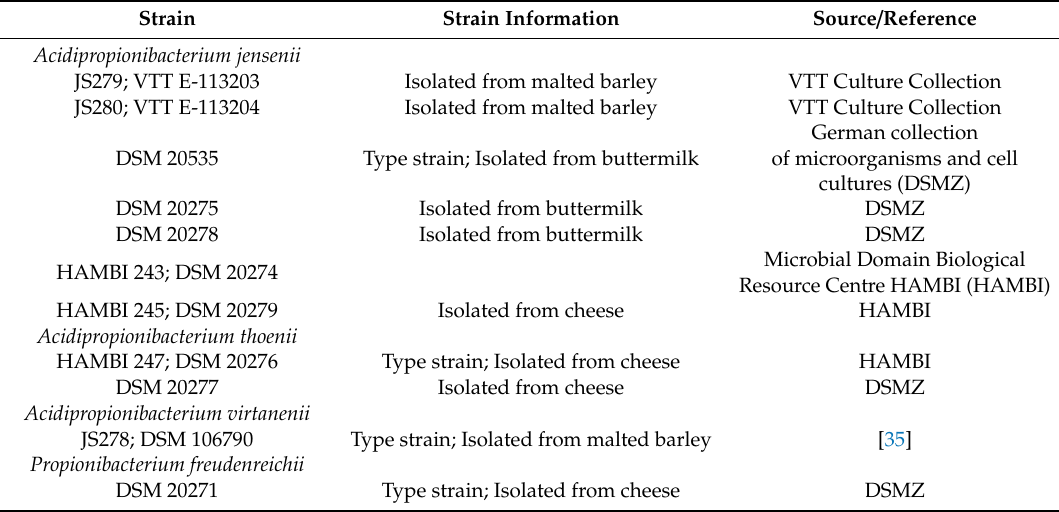
Table 1. Bacterial strains used in this